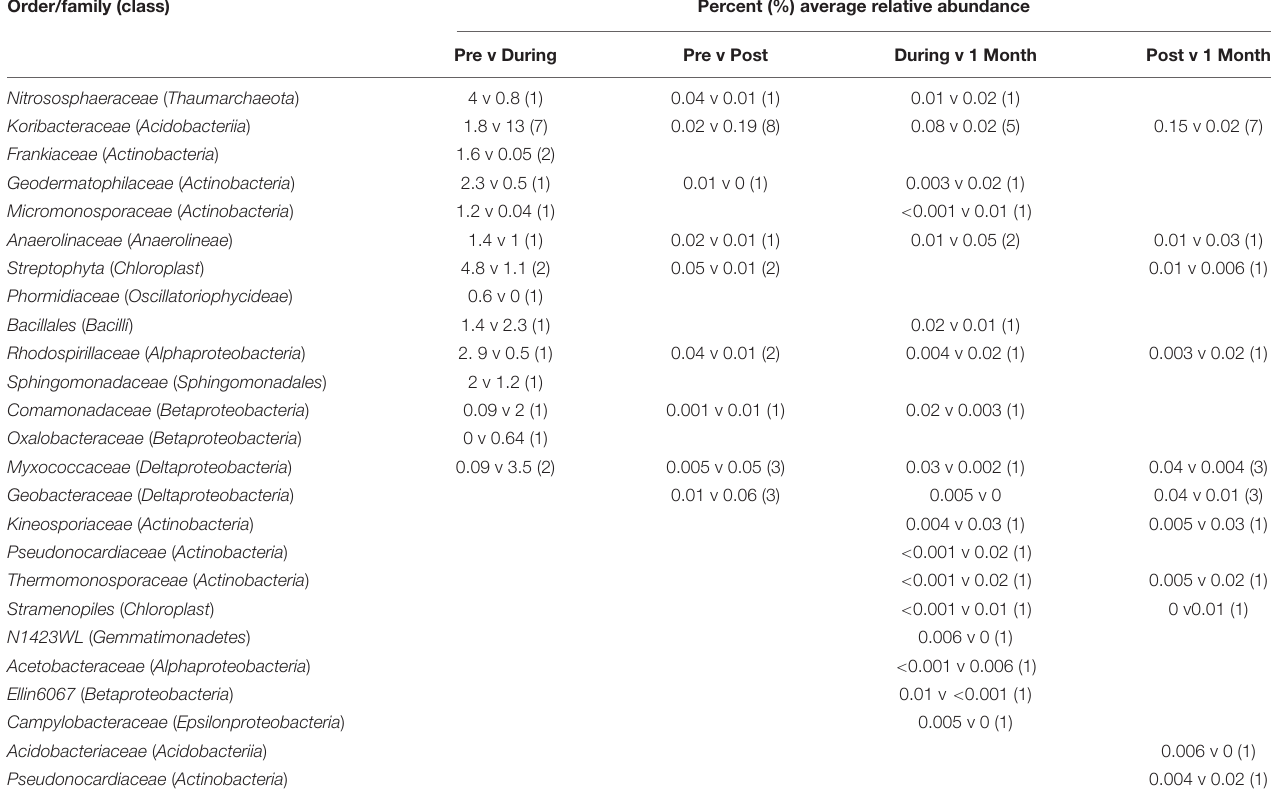
TABLE 2 | The SIMPER table of OTUs driving microbial community differences between phases. Order/family